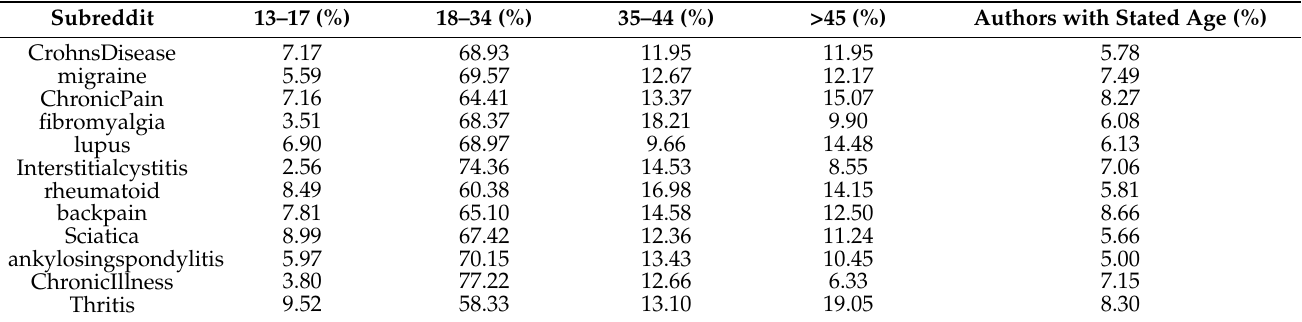
Table 3. Age distribution per subreddit.